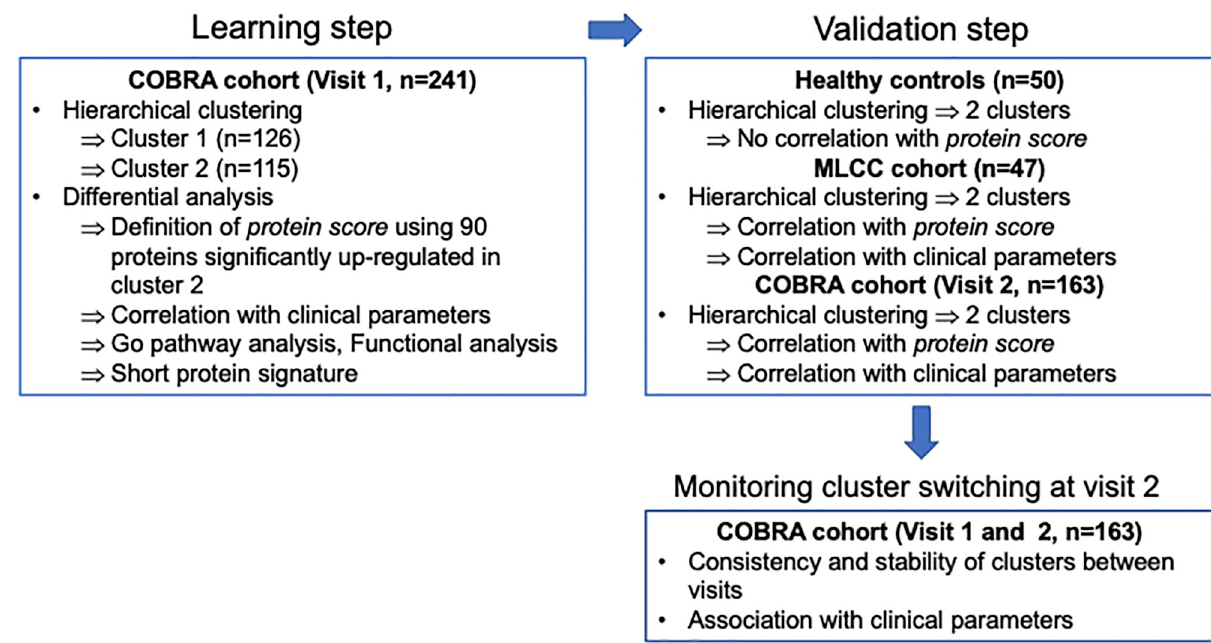
Fig 1. Study flow diagram. Stable COPD patients (n = 241) were included in the COBRA cohort at visit 1 and serum SOMAscan analyses were performed. Two COPD clusters, Cluster 1 (n = 126) and Cluster 2 (n = 115) with distinct protein expression patterns were identified through unsupervised hierarchical clustering. The differentially expressed proteins in Cluster 2 were submitted to GO pathways analysis for further functional enrichment study, then median expression values from 90 proteins up-regulated in Cluster 2 (defined as “protein scores”) were generated for each COPD cluster. Association studies were performed between COPD clusters or corresponding protein and clinical parameters. The evolution of the clinical outcomes and of proteomic profiles was assessed in 163 COPD patients out of the 241 having a follow up visit (visit 2) after inclusion (visit 1). Expression patterns associated with Cluster 1 (n = 97) and Cluster 2 (n = 66) were verified in COBRA cohort at visit 2 on the basis of protein scores previously defined at visit 1. Protein signatures representative of each COPD cluster were identified to monitor clinical patient stability at visit 2. SOMAscan data obtained in the COBRA cohort were validated in a separate group of 47 COPD patients originating from the MLCC cohort. Serum samples from n = 50 control healthy subjects were included for comparisons.